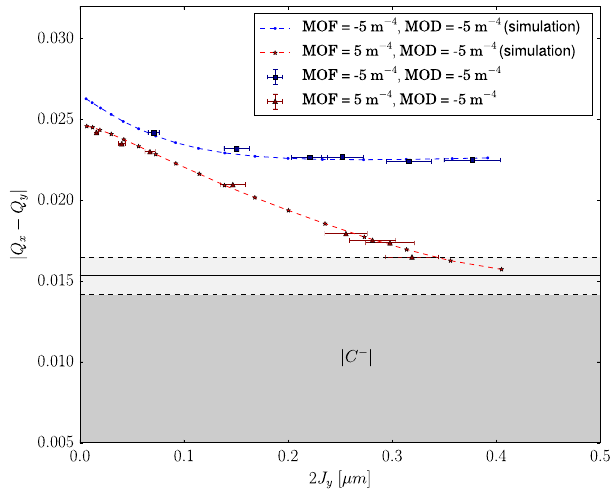
FIG. 1. The difference between the fractional horizontal and vertical tune as a function of the vertical action for free oscillations. The excitation was done using a kicker magnet and the settings of the octupoles were: MOF ¼ − 5 m − 4 , MOD ¼ − 5 m − 4 and MOF ¼ 5 m − 4 , MOD ¼ − 5 m − 4 . The fractional tunes were Q x ¼ 0 . 285 and Q y ¼ 0 . 31 . The dark gray area shows the linear j C − j and the light gray area shows the uncertainty of the measured